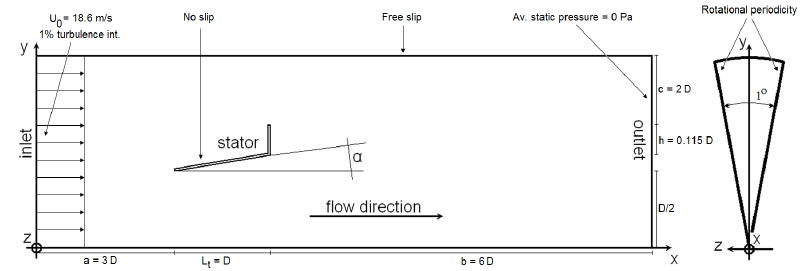
Figure 1: Simulation domain of the proposed numerical model.